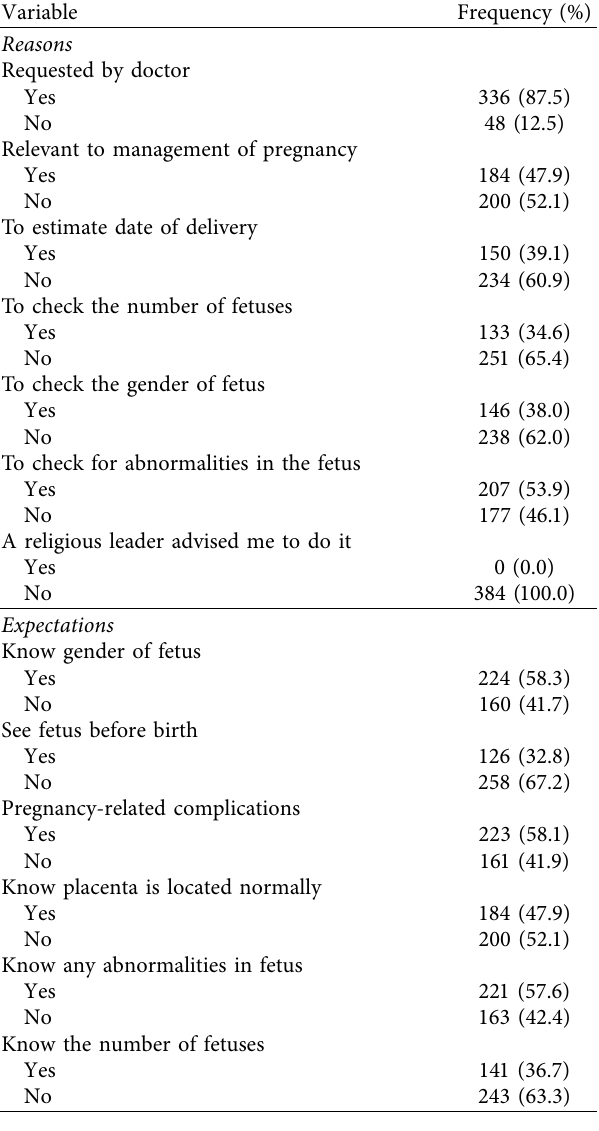
Table 4: The women’s reasons for undergoing ultrasound and expectations for the